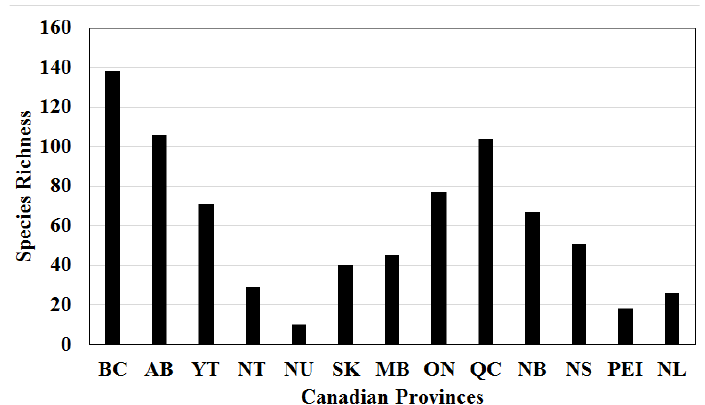
Figure 2. Plecoptera species richness by Canadian provinces. Abbreviations: AB – Alberta, BC – Brit- ish Columbia, MB – Manitoba, NB – New Brunswick, NL – Newfoundland and Labrador, NS – Nova Scotia, NT – Northwest Territories, NU – Nunavut, ON – Ontario, PEI – Prince Edward Island, QC – Quebec, SK – Saskatchewan, and YT –